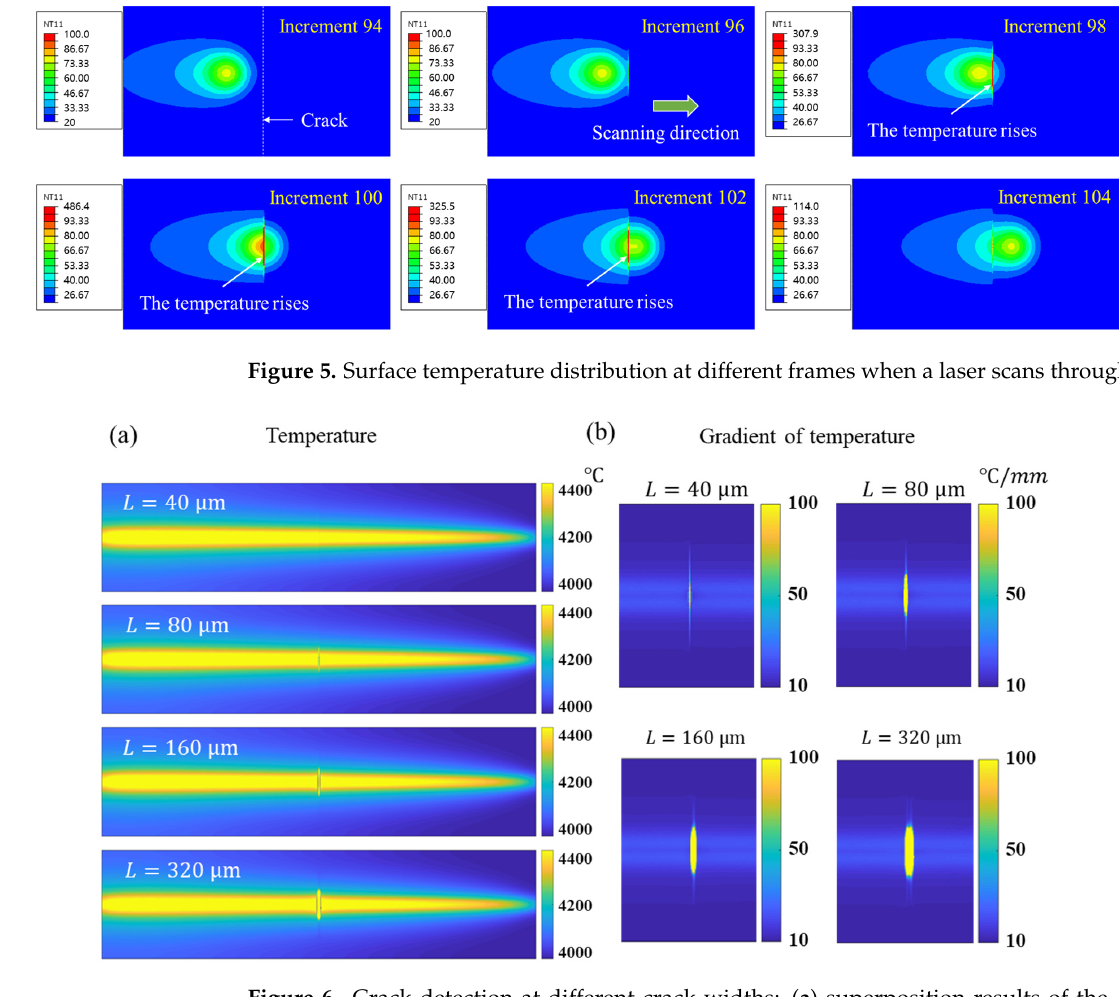
Figure 6. Crack detection at different crack widths: ( a ) superposition results of the ∆ T ; ( b ) the superposition results of T G